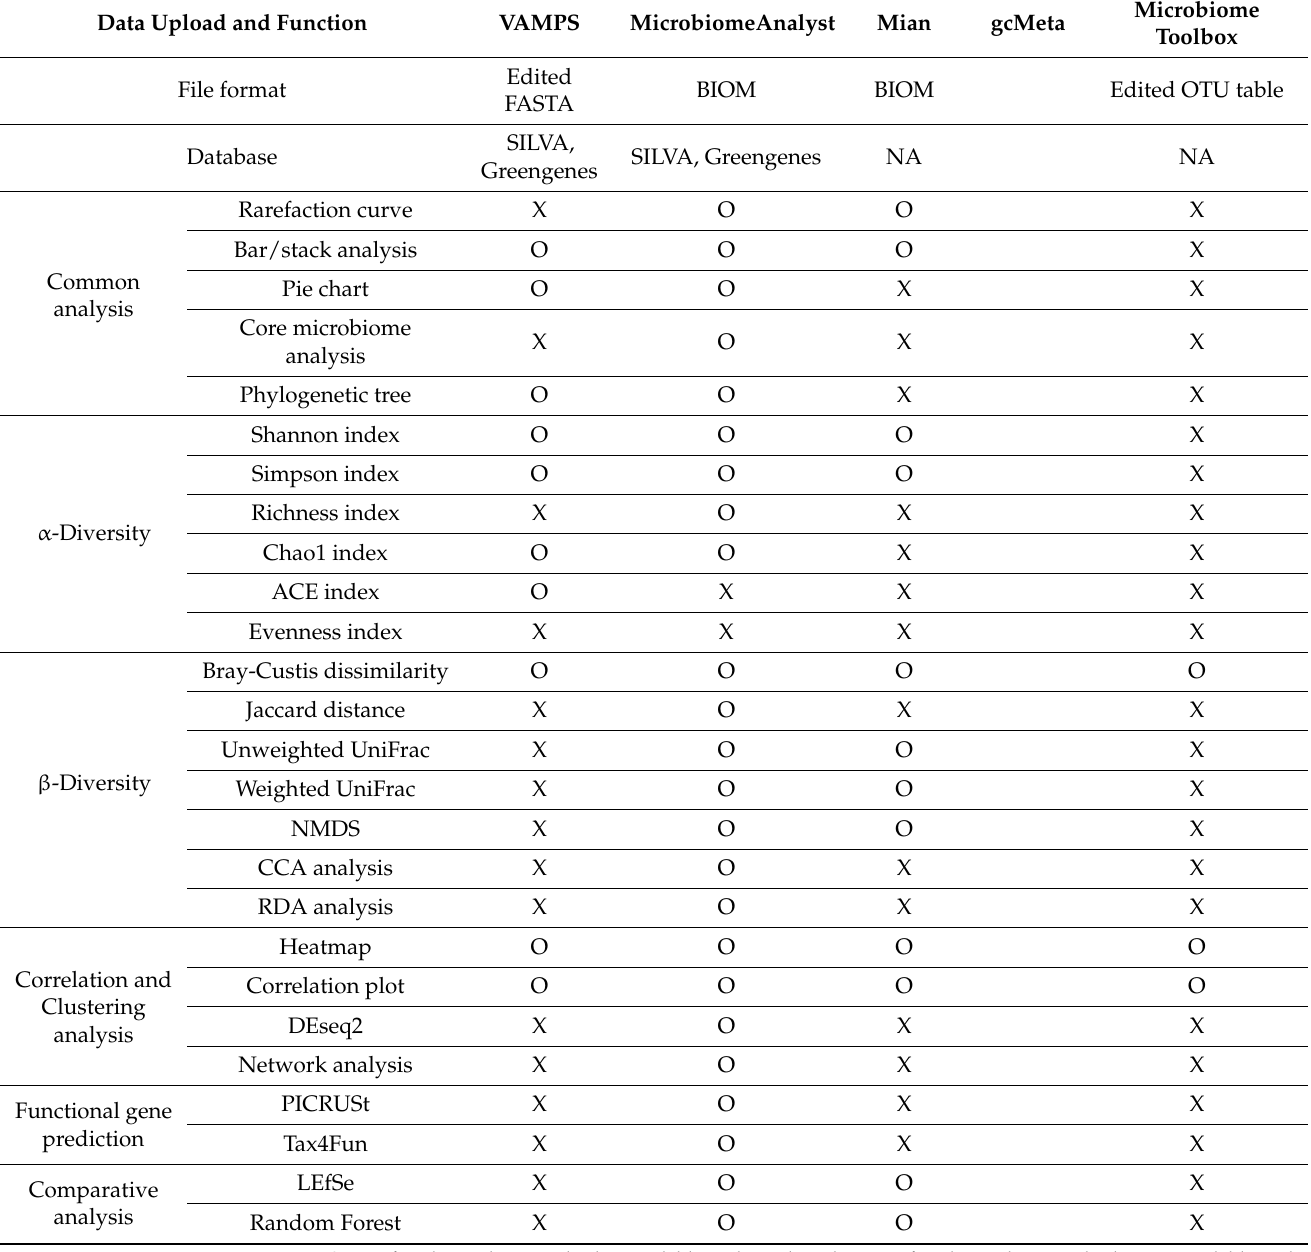
Table 1. Comparison of web-based microbiome